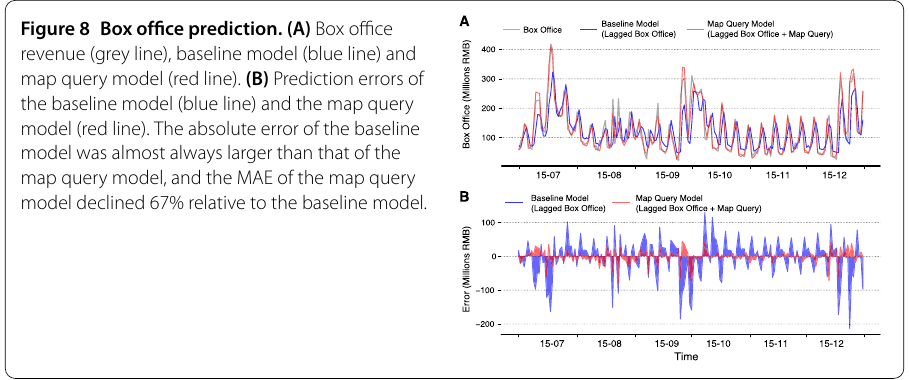
Figure 8 Box office prediction. (A) Box office revenue (grey line), baseline model (blue line) and map query model (red line). (B) Prediction errors of the baseline model (blue line) and the map query model (red line). The absolute error of the baseline model was almost always larger than that of the map query model, and the MAE of the map query model declined 67% relative to the baseline